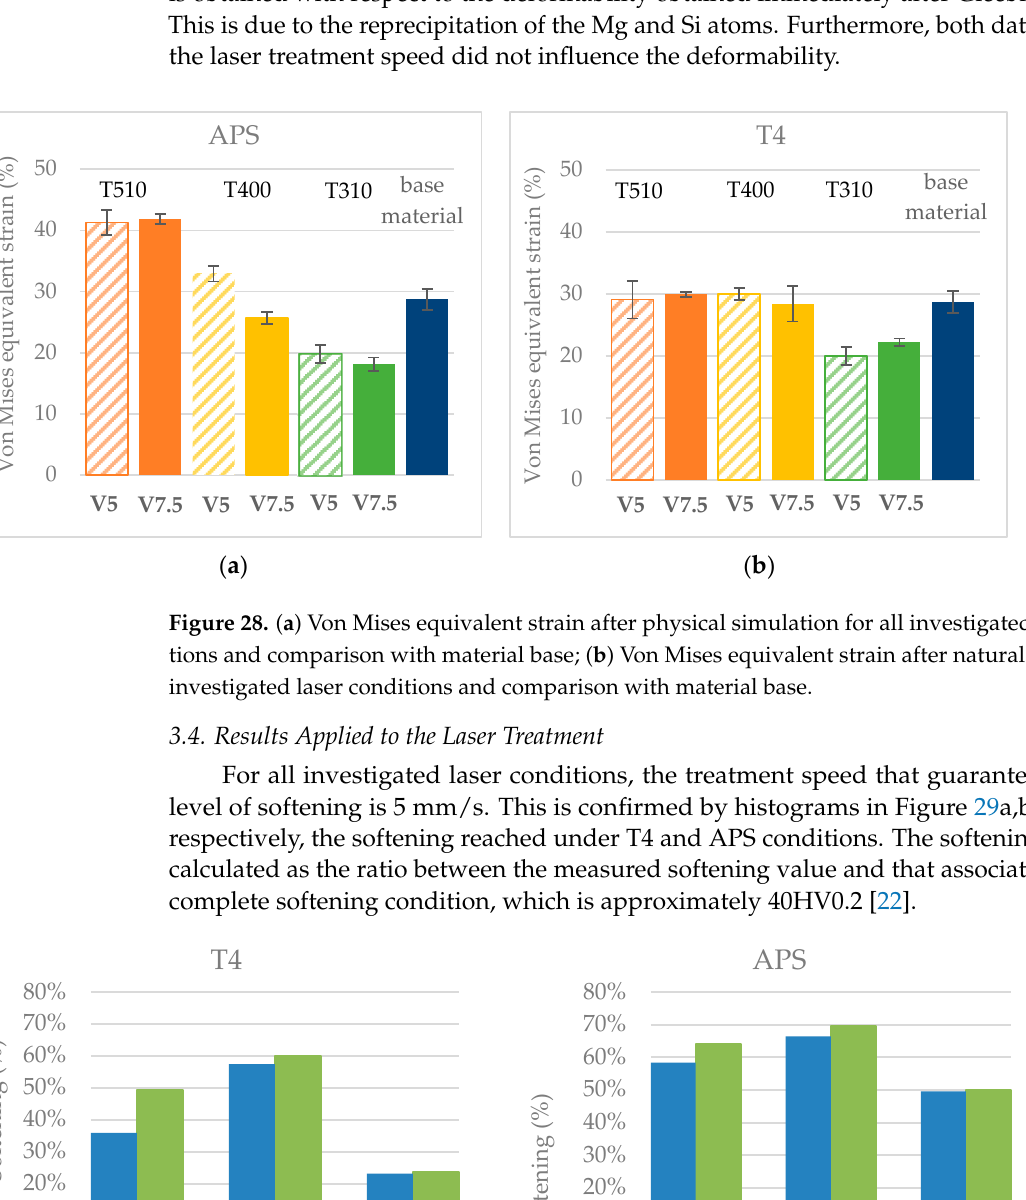
( b ) Figure 27. ( a ) Stress–strain curves of base material and those obtained in APS state for laser thermal cycles at a treatment speed equal to 5 mm/s; ( b ) Stress–strain curves of base material and those obtained in T4 state for laser thermal cycles at a treatment speed equal to 5 mm/s. During the tensile tests, the tension state was not completely monoaxial due to the geometry of the adopted specimens; therefore, the results shown in Figure 27a,b offer a qualitative indication of the tensile strength and the elongation at break for different peak temperatures and for each material state (APS or T4). The results of the tensile tests in